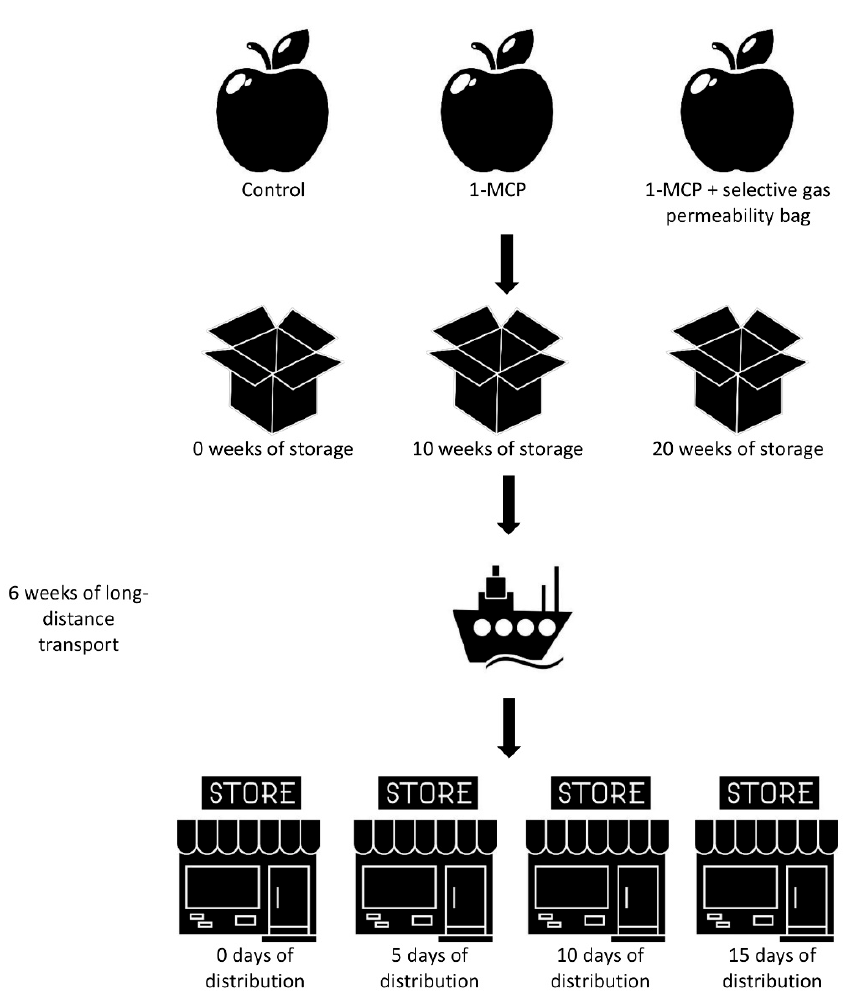
Figure 1. The procedures applied in the experimental groups of ‘Idared’ apples.